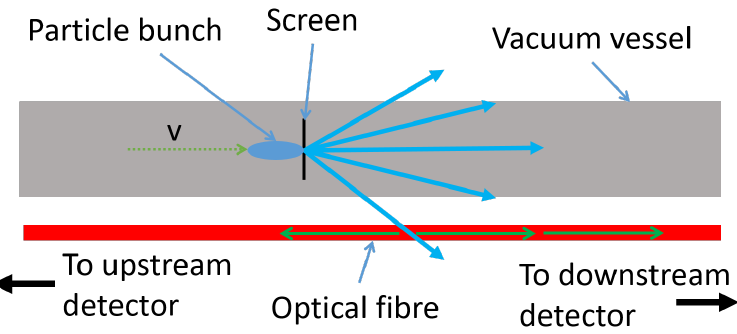
Figure 3. A schematic of a loss event and the location measurement by the optical fibre system. The charged shower is represented by the blue arrows and the subsequent Cherenkov radiation by the green